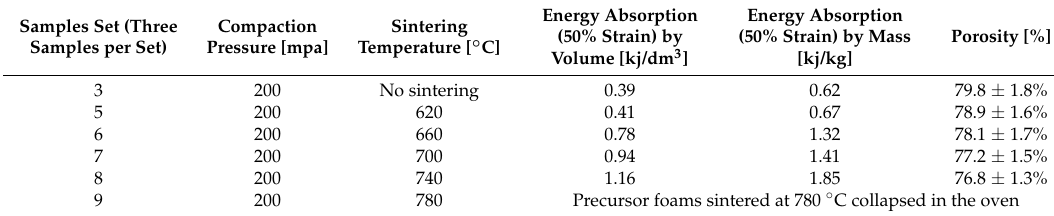
Table 2. Investigated parameters in experimental scale-up